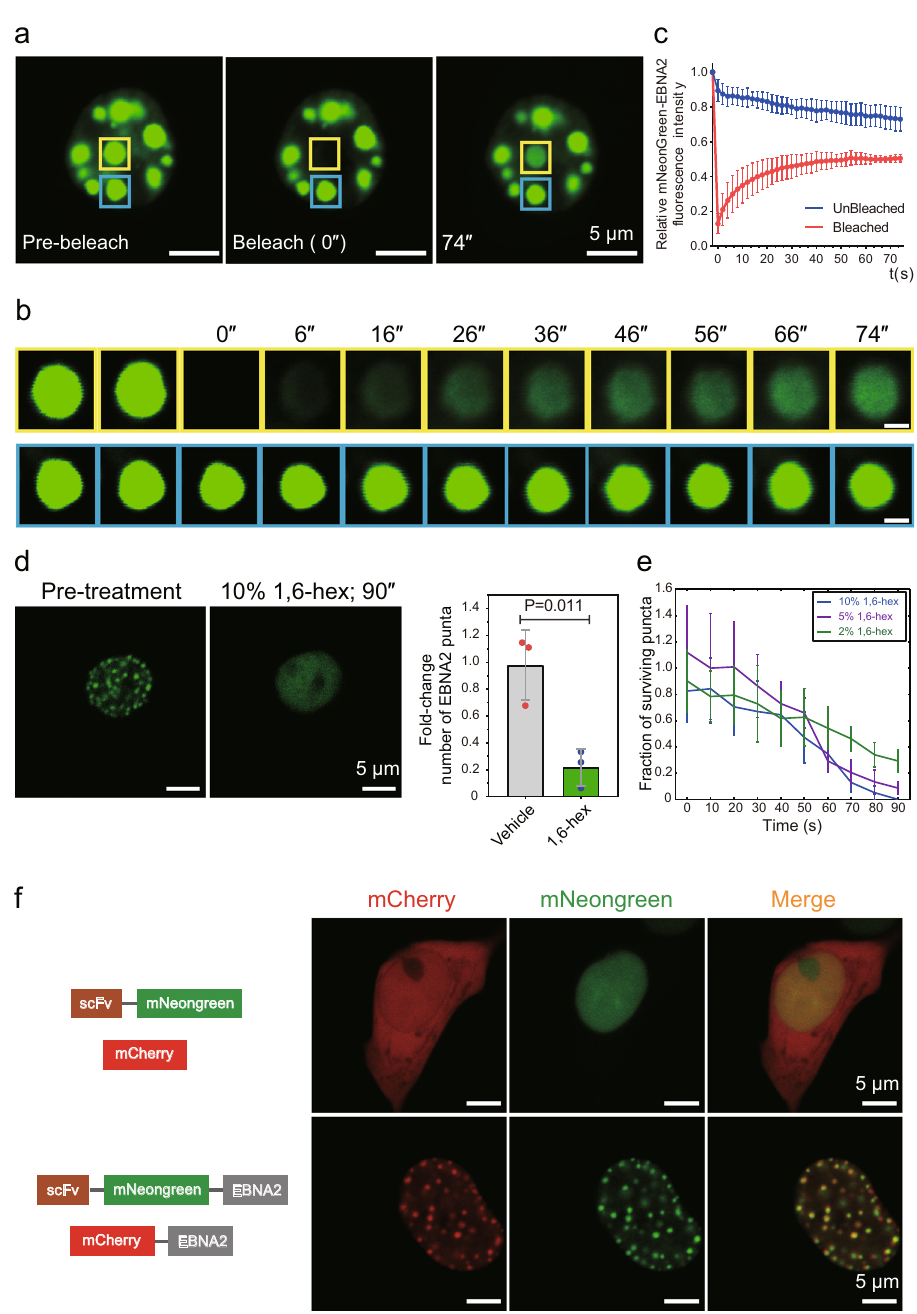
Fig. 2 EBNA2 undergoes phase separation in host cells. a Image and b time-lapse and close-up view of a mNeonGreen EBNA2 droplet (yellow box) before (left), during (middle), and after (right) photobleaching. The blue box highlights an unbleached region for comparison. Time relative to photobleaching (0 s) indicated. Scale bars, 1 μ m ( b ). c Quanti fi cation of FRAP for mNeonGreen-EBNA2 puncta. The bleaching event occurs at t = 0 s. For the bleached area and the unbleached control, background-subtracted fl uorescence intensities are plotted relative to a prebleach time point ( t = − 2 s). Data are plotted as mean + SD ( n = 3). d Representative images of mNeonGreen-EBNA2 before and after treatment with 10% 1,6-hexanediol for 90 s (left). The fold change of the number of mNeonGreen-EBNA2 puncta observed after the addition of 1,6-hexanediol to the fi nal concentration of 10% (right). e Number of nuclear puncta formed by mNeonGreen-EBNA2 surviving over time upon addition of 1,6-hexanediol at different concentrations. Error bars represent SE. f Schematic representation of recombinant mNeonGreen/mCherry fusion proteins used in this experiment (left). The mNeonGreen-EBNA2, mCherry-EBNA2, mNeonGreen, and mCherry plasmids were transiently transfected into 293T cells. Double immuno fl uorescence revealed co-localization of mNeonGreen-EBNA2 and mCherry-EBNA2 proteins in HEK 293T cells protein-DNA interactions with a small number of cells (Fig. 7). on the Illumina sequencing platform. After mapping, we got The sorted mNeonGreen-positive cells were treated with anti- 42349 H3K27ac peaks from the EBNA2 + cells, of which 9121 H3K27ac antibody and protein G-Tn5 transposase after per- peaks were unique in the EBNA2 + cells (Fig. 7b). Analysis of the meabilization. The libraries were ampli fi ed for deep-sequencing signal strength of the common peaks showed that the H3K27